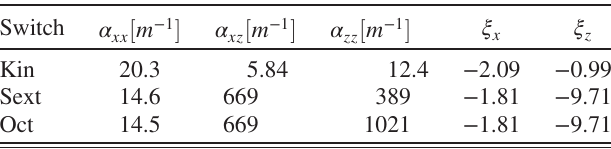
TABLE I. The effect of the nonlinear fringe field on chroma- ticities ξ and nonlinear detuning parameters α of Tsinghua Thomson scattering X-ray source (TTX). The 3rd-order and 4th-order fringe field kicks are gradually turned on, and the nonlinear optics parameters are measured from the tracking data. “ Kin ” represents the case when only linear fringe field kicks are used in tracking and thus the nonlinear optics contribution comes purely from the nonlinear kinetics. “ Sext ” represents the case when a sextupolelike fringe field kick is added, and “ Oct ” represents the case when an octupolelike fringe field kick is finally added. The 1st-order chromaticity ξ comes from a sextupolelike potential, and thus the octupolelike fringe field kick does not contribute. And since the octupolelike fringe field kick is vertical, it contributes only on the vertical detuning